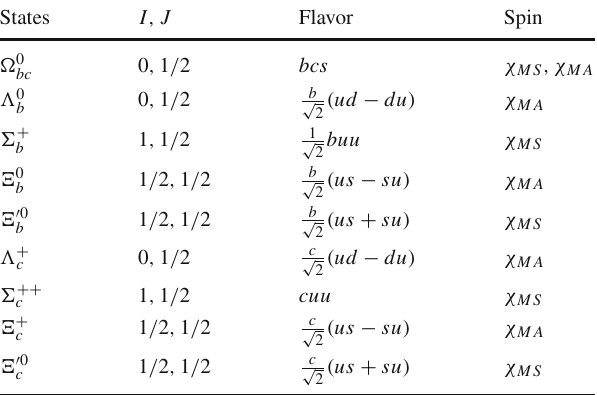
meson–baryon channels according to the spin wave func- tions of baryons, i . e . , χ MS , χ MA or χ S . Hence we have the blocks of coupled